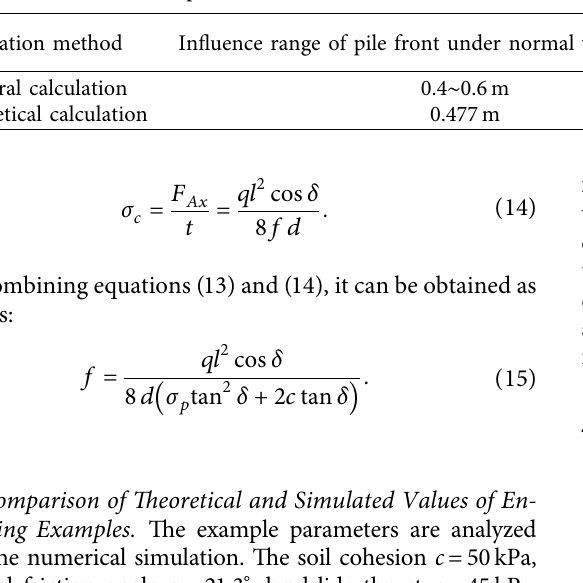
Figure 7: Schematic diagram of the force of the midspan section under the action of swelling force. Table 4: Comparison between theoretical and simulated values of the combined efect range of pile and soil.